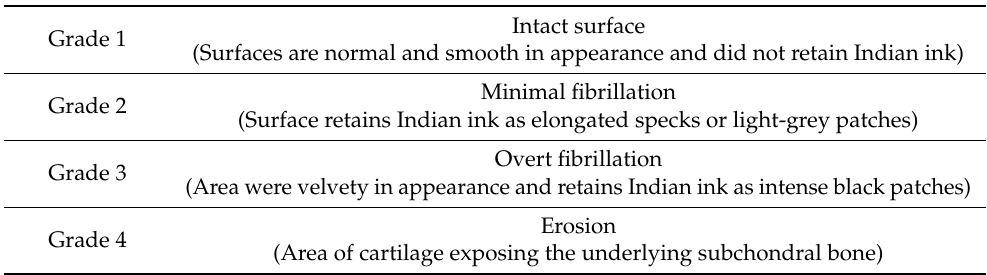
Table 1. Classification of cartilage lesions based on macroscopic evaluation after Indian ink staining.